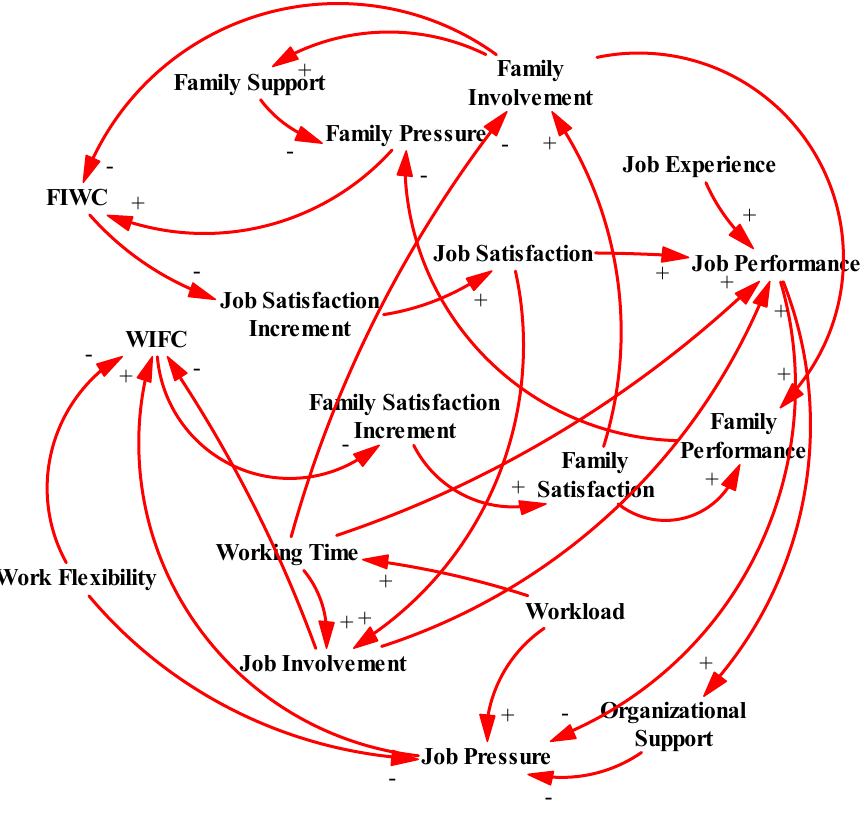
Figure 3. Causal relationship model for construction employee’s WFC evolution.